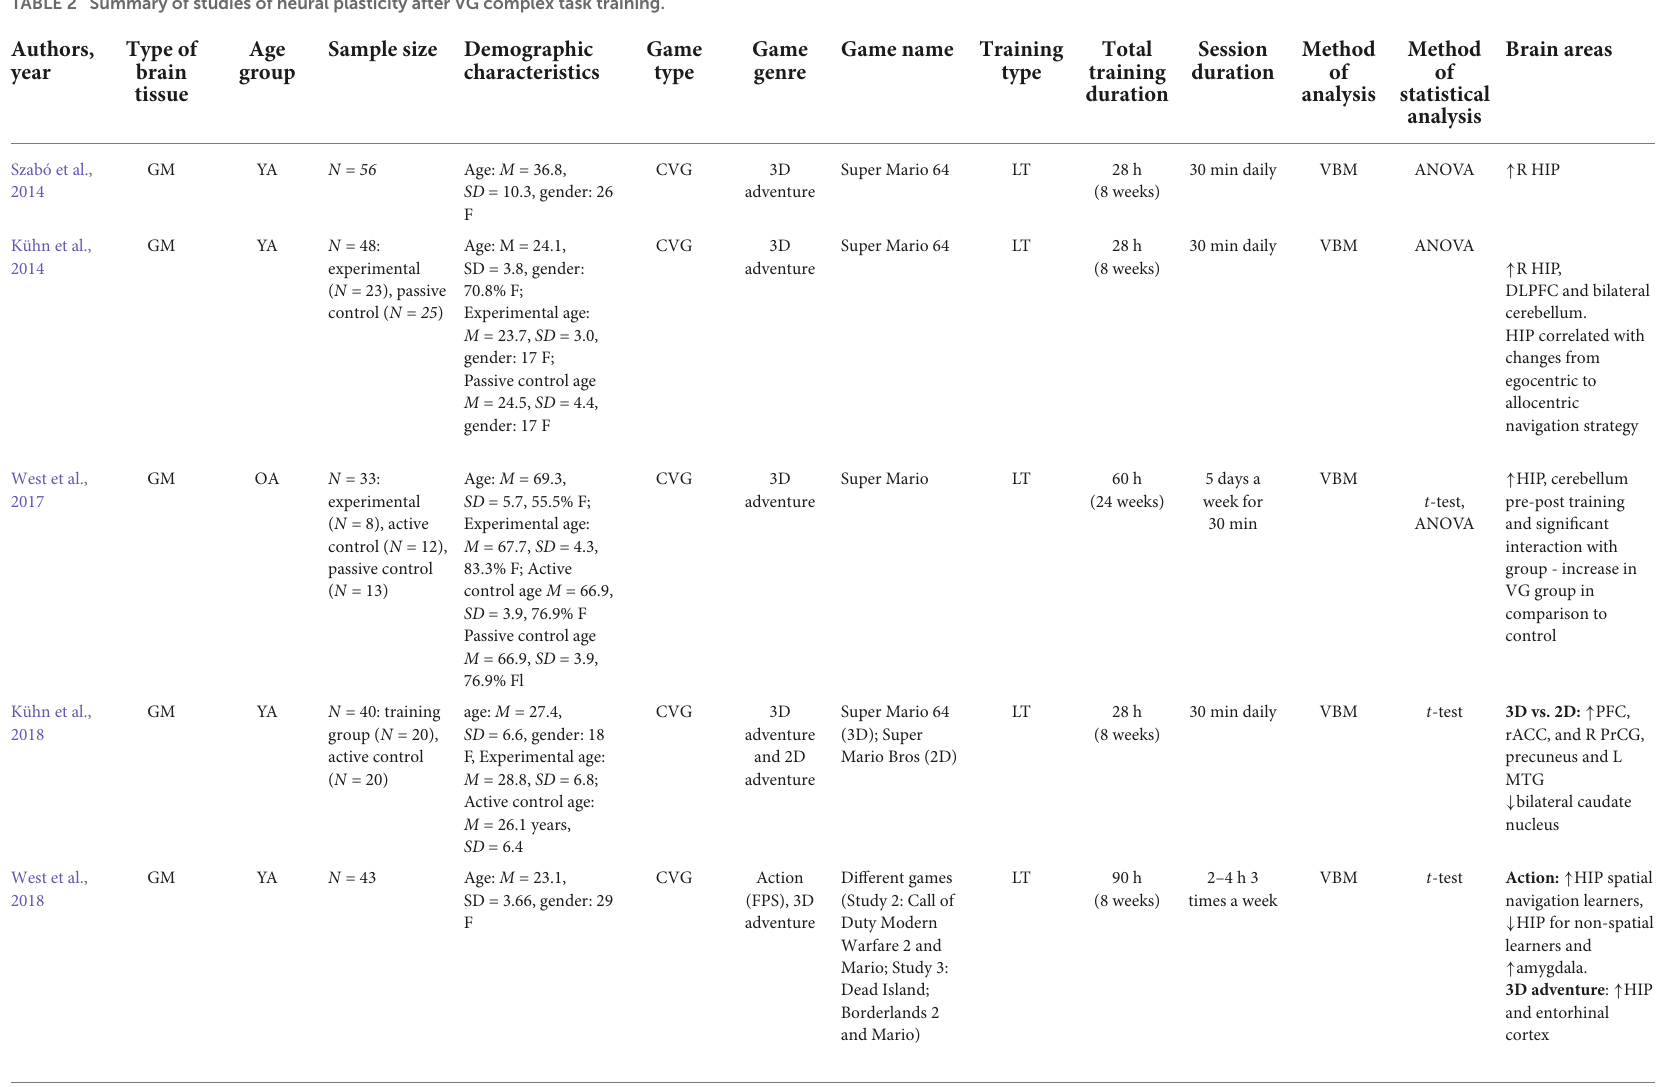
TABLE 2 Summary of studies of neural plasticity after VG complex task